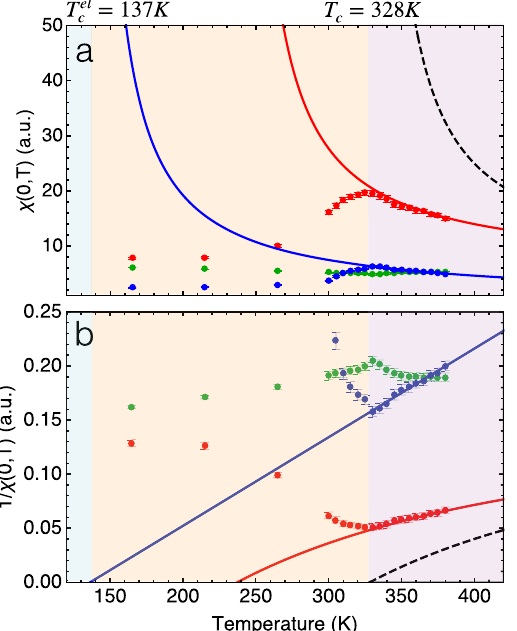
Fig. 5 Static B 2g susceptibility derived from the Fano fi ts to the Raman data shown in Fig. 3. a Temperature dependence of the ac quadrupole static susceptibilities χ ac (0, T ) derived from the decom- ð ω ; T Þ (Fig. 3): excitonic (blue), phononic (green) and position of χ 00 ac combined (red). Above T c (purple background), while the phononic susceptibility mildly decreases on cooling, the electronic and combined ones grow: lines represent an extrapolation using the Fano model parameters above 350 K. The extrapolated electronic ¼ 137 ð 16 Þ K (blue background below). susceptibility diverges at T el c Black dashed line illustrates the total susceptibility including the exciton-strain coupling (see text and Supplementary Note 1.3.4), that diverges at the actual transition temperature T c . Below T c (pink background), the electronic and combined susceptibilities are suppressed, indicating the formation of the order parameter. b Same for inverse static susceptibilities 1/ χ ac (0, T ). Extrapolated electronic inverse susceptibility shows a linear (Curie-Weiss) , while the combined inverse susceptibility behavior vanishing at T el c is nonlinear and vanishes at a higher temperature, showing that the coupling to otherwise stable (green points) optical phonons can strongly enhance transition temperature. Same is true for coupling to acoustic strain, that can further enhance it to the actually observed T c . Error bars in all panels are the 95% con fi dence intervals of the Fano model fi